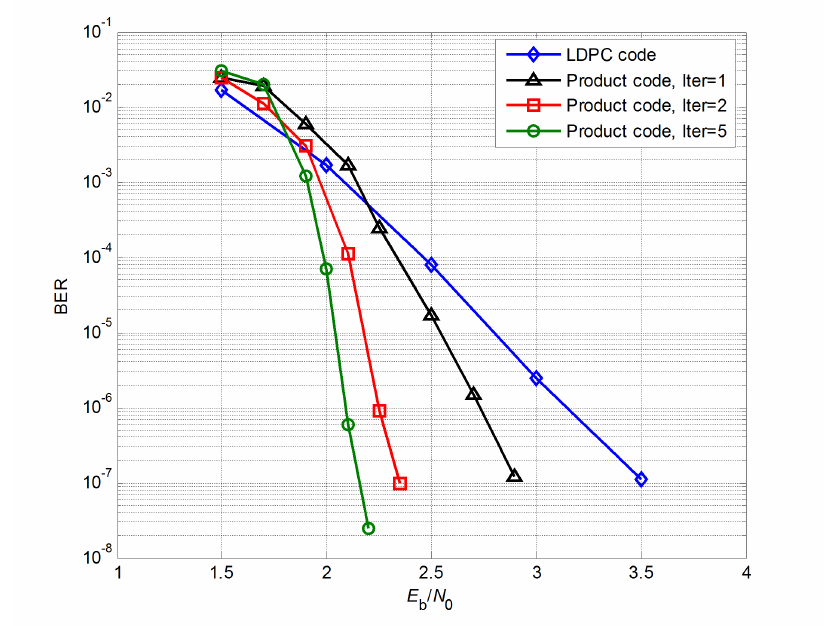
Figure 14. FPGA evaluation results of product codes with LDPC (576, 288) and Hamming (511,